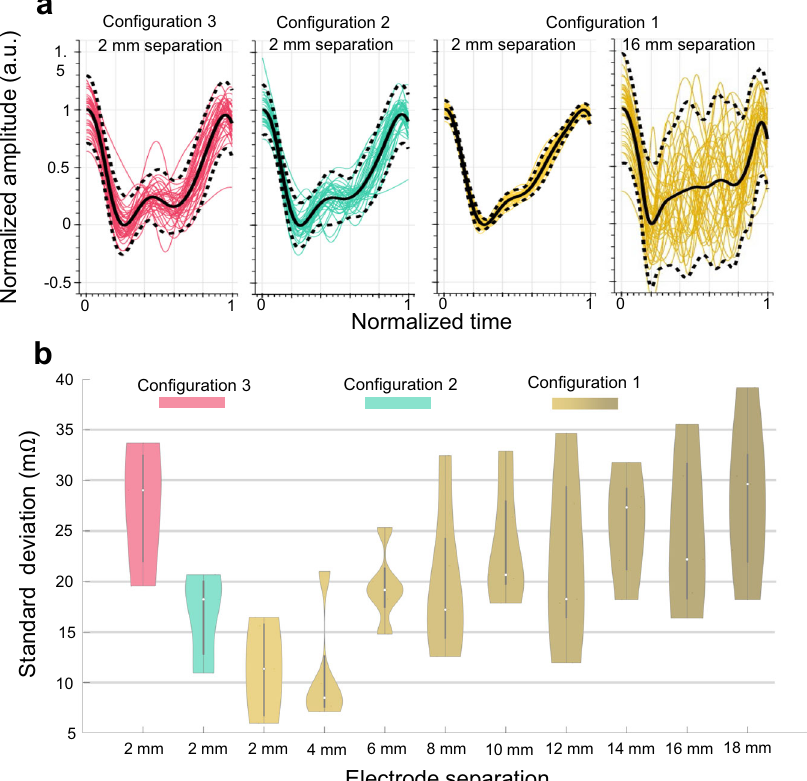
Fig. 5 Bioimpedance signal consistency analysis results for different electrode con fi gurations and sizes for data collected from N = 5 participants. a Bioimpedance signals over an example 30-seconds trial for different electrode con fi gurations, visualizing the signal consistency over a constant period. The highest consistency is achieved with 2 mm ring separation using Con fi guration 1 (yellow) compared to Con fi guration 2 (green) and 3 (pink). b Violin plots for standard deviation (SD) metric used for signal consistency analysis calculated with different electrode con fi gurations and separations. Violin plots include SD values averaged for all the trials of each participant and combined together. Box plots show the median and the Q25 and Q75 ranges. Colors used to identify separations and con fi gurations. Here 2 mm and 4 mm electrode separations with Con fi guration 1 yield the lowest SD values indicating a higher overall bioimpedance signal